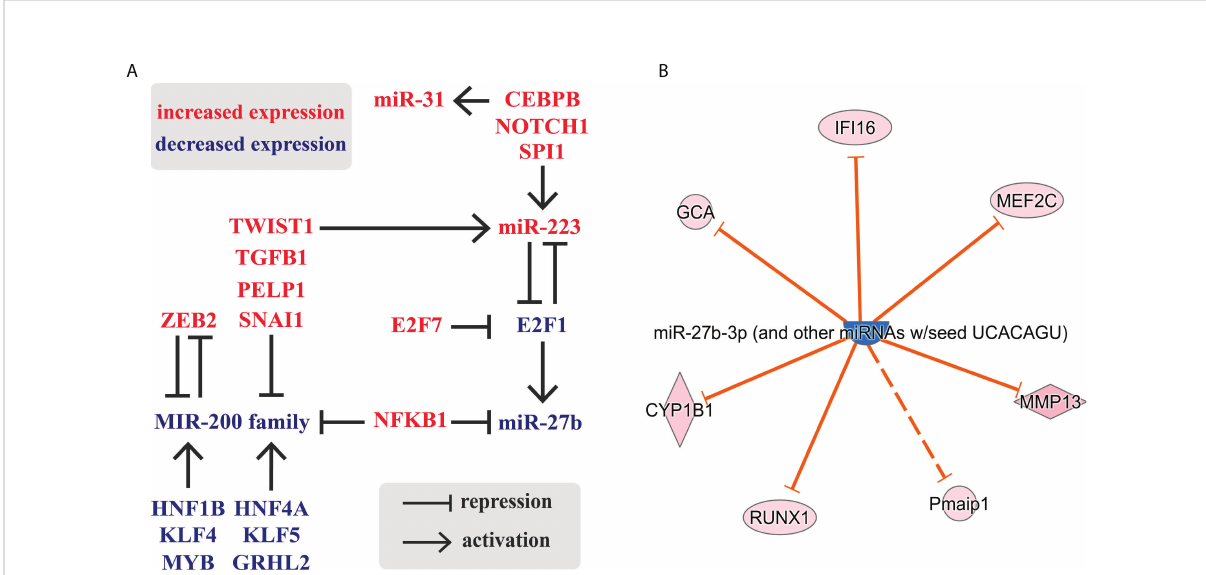
FIGURE 6 Schematic representation of a possible regulatory circuit of transcription factors and microRNAs during colon in fl ammation. (A) The comparison of in fl amed to unin fl amed colon samples identi fi ed genes and miRNAs (RNA-Seq (24) and miRNA-Seq (this study), respectively) with altered expression. (B) Selection of miR-27b targets with altered expression in the in fl amed rat colon samples based on RNA-Seq data and IPA knowledge base. Legend of molecule shapes is available from reference